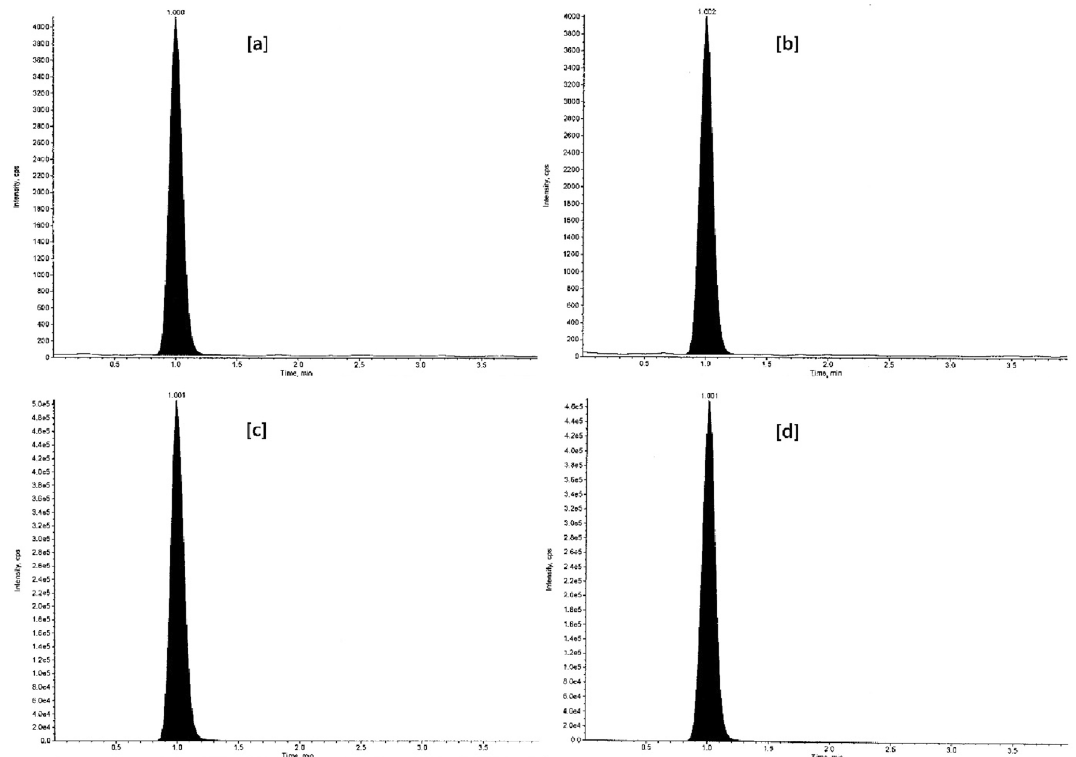
Figure 9. Representative chromatograms of O -desmethylvenlafaxine at ( a ) LQC (spiked), ( b ) LQC (pure standard solution), ( c ) HQC (spiked), and ( d ) HQC (pure standard solution)